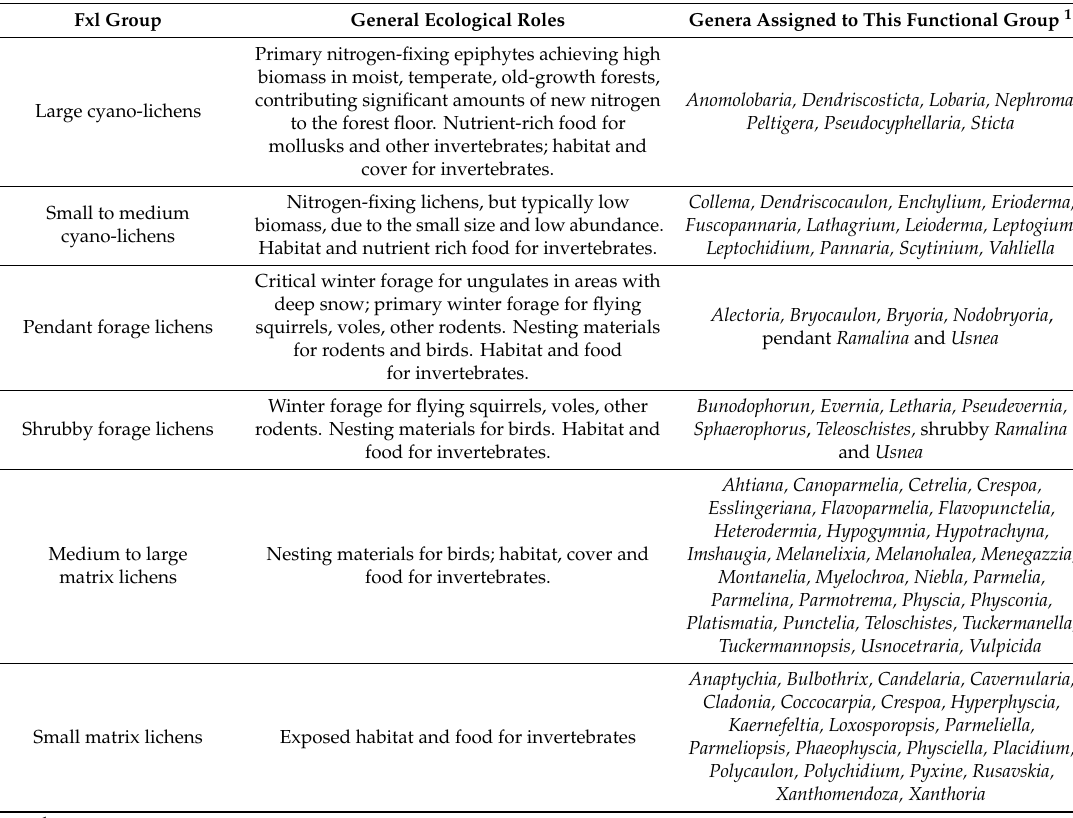
Table 1. Functional group ecological roles and a ffi liated lichen